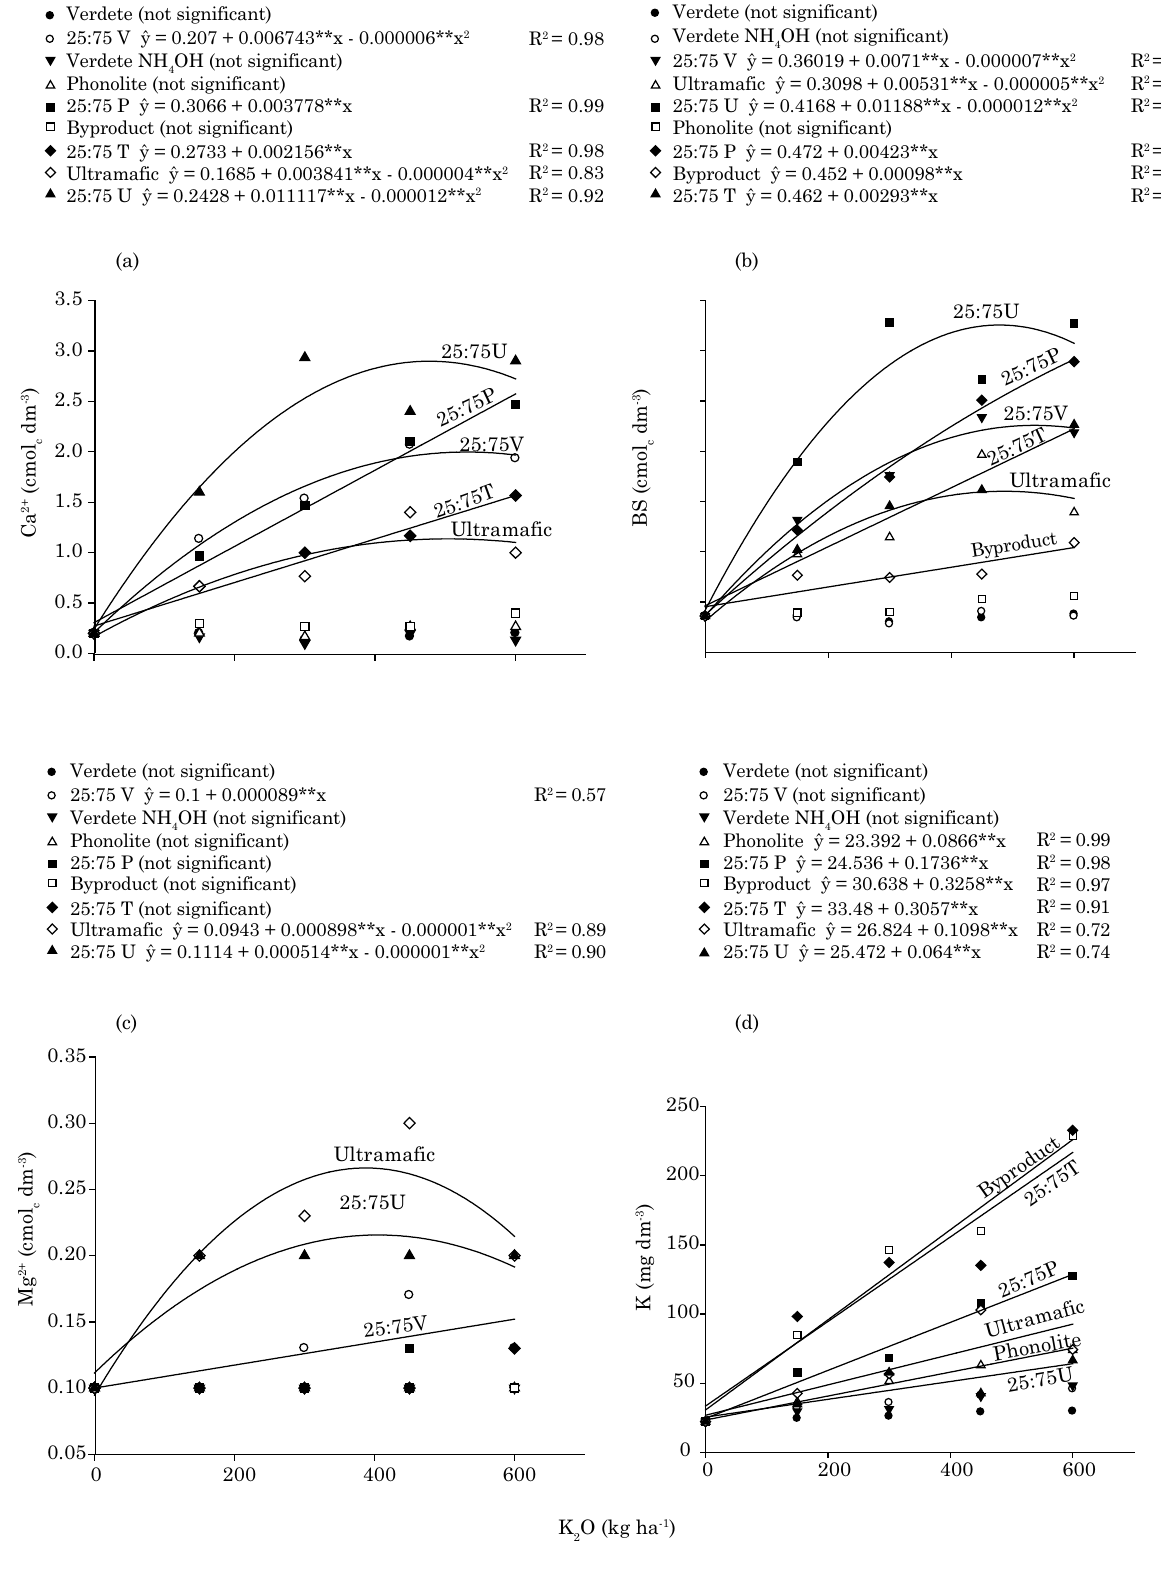
Figure 2. Regression equations for content of: a) calcium; (b) sum of bases (SB); (c) magnesium; and (d) potassium in soil as a function of K 2 O rates after a 45-day incubation. * Significant at 5 % by Scott Knott